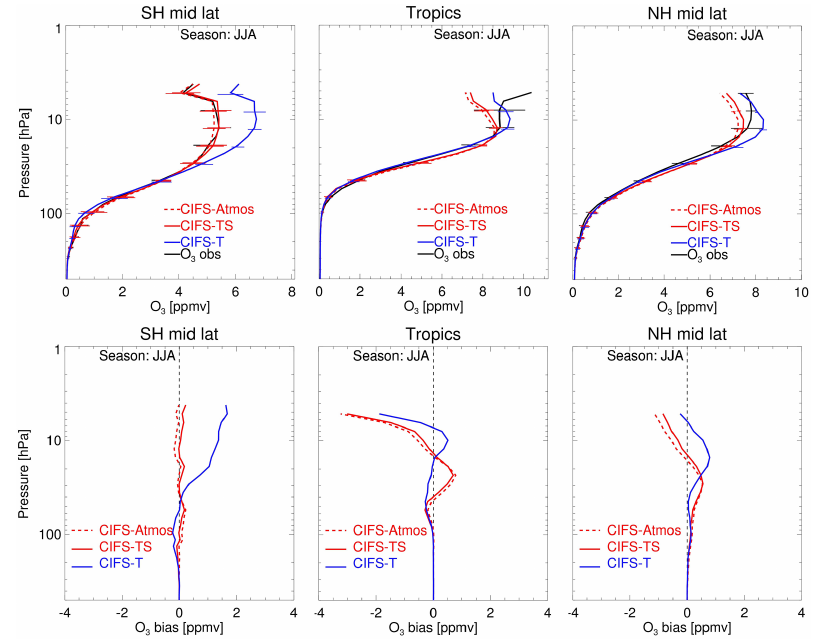
Figure 4. Same as Fig. 3 but for June–July–August 2009 and